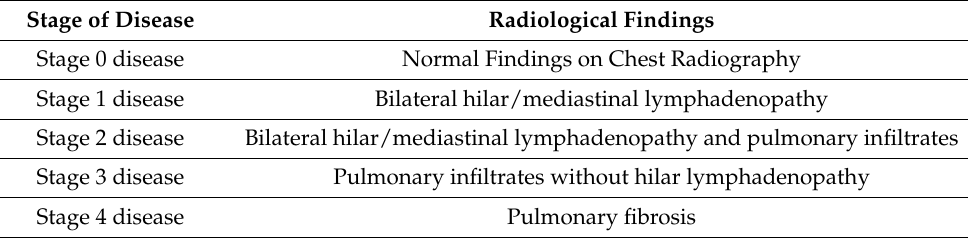
Table 3. Radiological classification of pulmonary sarcoidosis